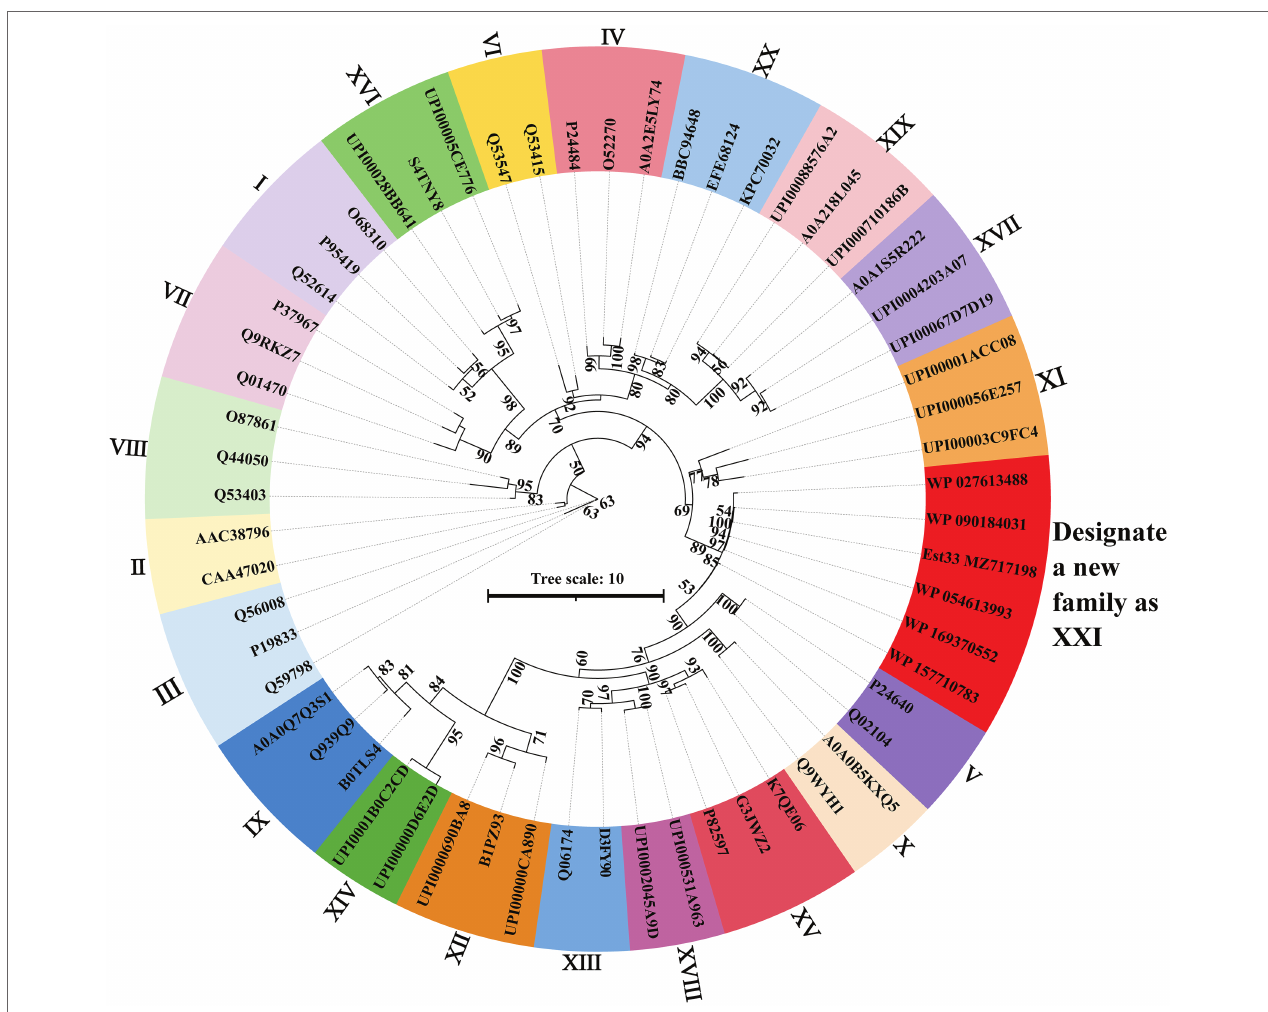
FIGURE 2 | Phylogenetic analysis of Est33, its homologs, and other esterase families. The maximum likelihood phylogenetic tree was constructed using the IQ- TREE webserver with the auto substitution model and modified by iTOL v6. Bootstrap analysis of 1,000 replicates was conducted, and values above 50% are shown. Supplementary Table S1 shows the sources of all proteins